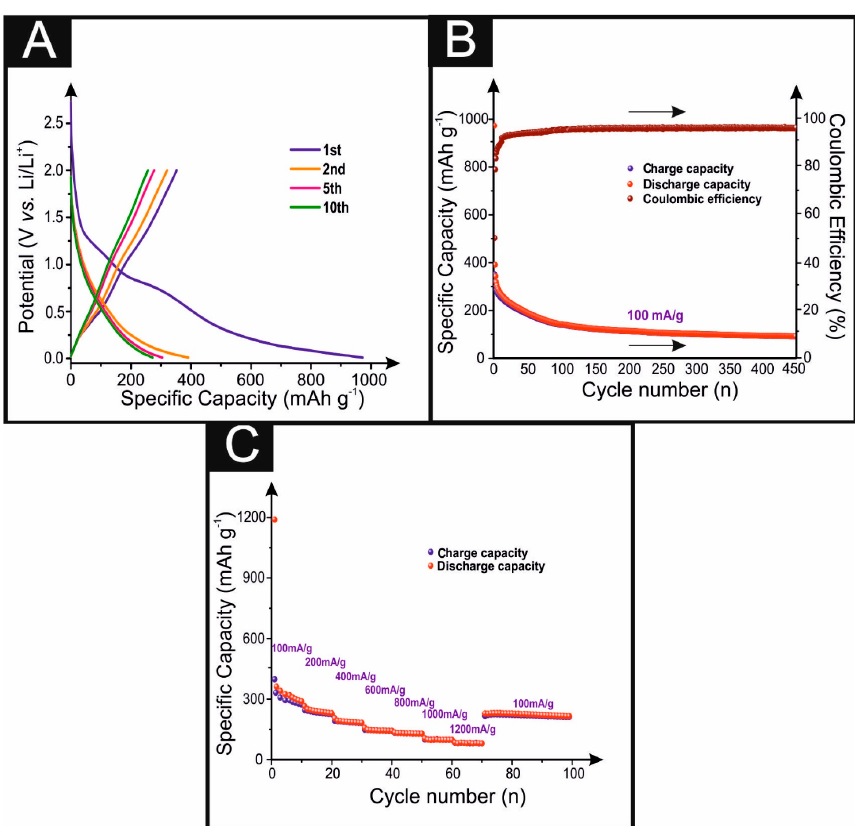
Figure 3. Charge/discharge profiles ( A ), cycling properties/coulombic efficiency ( B ), and rate capability of the graphene@SiC anode ( C ). These tests were carried out in batches of three, with an overall error within 10%–15% of the specific capacity.